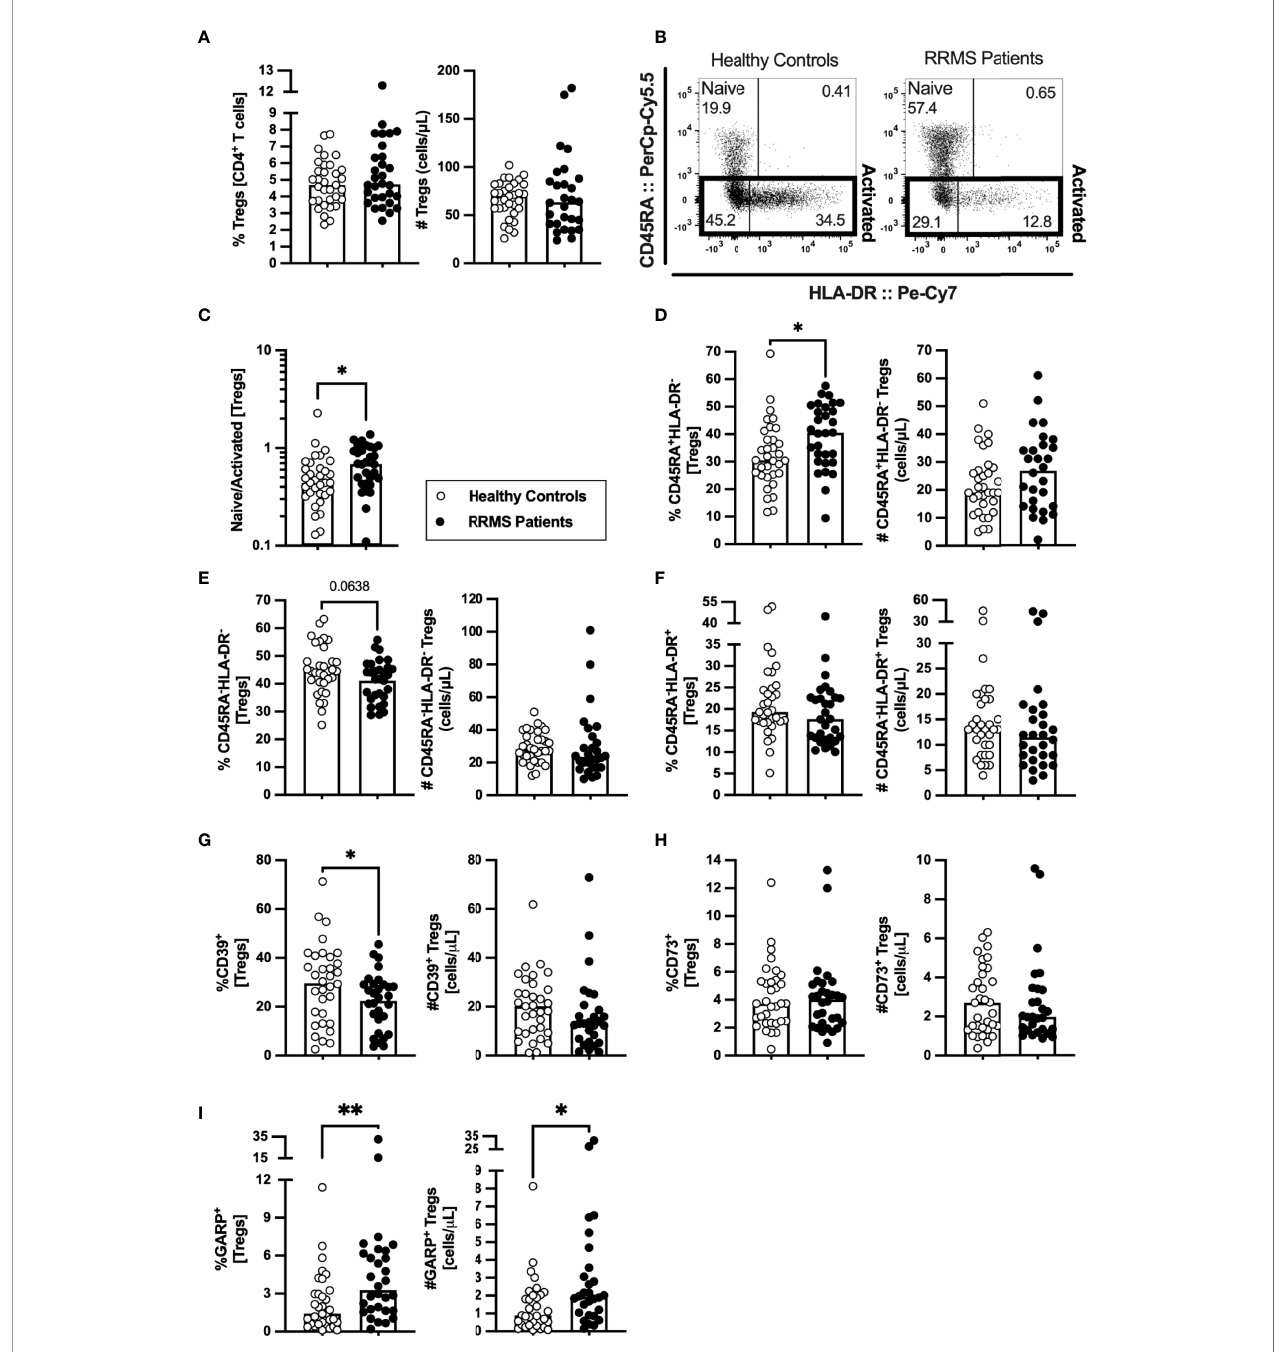
FIGURE 4 | A higher naïve to activated Tregs ’ ratio characterize newly diagnosed RRMS patients. Percentage and number of Tregs are represented for healthy controls (white circles) and newly diagnosed RRMS patients [black circles; (A) ]. Representative dot plot of Tregs subpopulations (B) : naïve (CD45RA + HLA-DR − ); activated HLA-DR − (CD45RA − HLA-DR − ); and activated HLA-DR + (CD45RA − HLA-DR + ). Total activated Tregs are the sum of the HLA-DR − and HLA-DR + subpopulations. Naïve to activated Tregs ’ ratio (C) . Percentages and numbers of Tregs subpopulations: naïve (D) , activated HLA-DR − (E) , and activated HLA-DR + (F) . Percentages and numbers of Tregs expressing suppressive markers: CD39 + (G) , CD73 + (H) , and GARP + (I) . The parametric Student ’ s t- test was performed in (D ; number), (E) ; percentage), and (G ; (percentage); the non- parametric Mann – Whitney U -test in (A, C) , ( D ; percentage), ( E ; number), (F) , ( G ; number), and (H, I) . Statistical outputs and effect size calculations in eTable 1 . In all graphs, each dot represents one individual, and the horizontal lines the groups ’ means or medians depending on the normal or non-normal distribution of the data, respectively. When differences were statistically signi fi cant ( p-value < 0.050), the p -value was represented by * for 0.010< p <0.050 and ** 0.001< p ≤ 0.010. Differences are maintained upon controlling for sex, age, and human cytomegalovirus IgG seroprevalence on multiple linear regression models ( eTable 7 ), except for the naïve/activated Tregs ’ ratio that becomes a tendency to be higher on patients with RRMS (C) , and the percentage of activated HLA-DR + Tregs that becomes a tendency to be lower in patients (F)